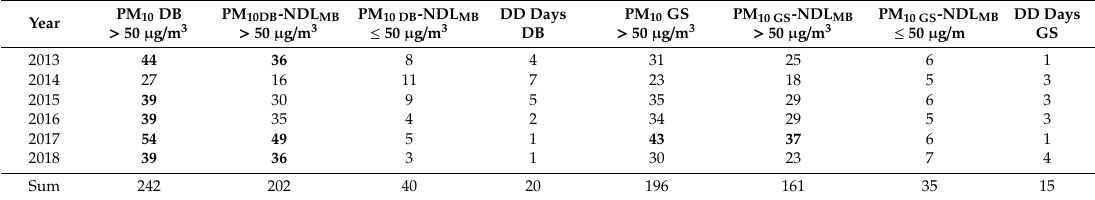
Table 3. Number of days with daily PM 10 > 50 µ g / m 3 at the urban-tra ffi c station Graz Don Bosco (DB) and the urban-background station Graz Süd (GS), number of days which are exceeding or falling below the 50 µ g / m 3 limit value after the subtraction of the NDL of the regional background station MB (NDL MB ) without any further evaluation as well as with the identification of desert dust (DD) days via model calculations. Amount of days exceeding the limit of 35 days / year with PM 10 concentrations > 50 µ g / m 3 are marked in